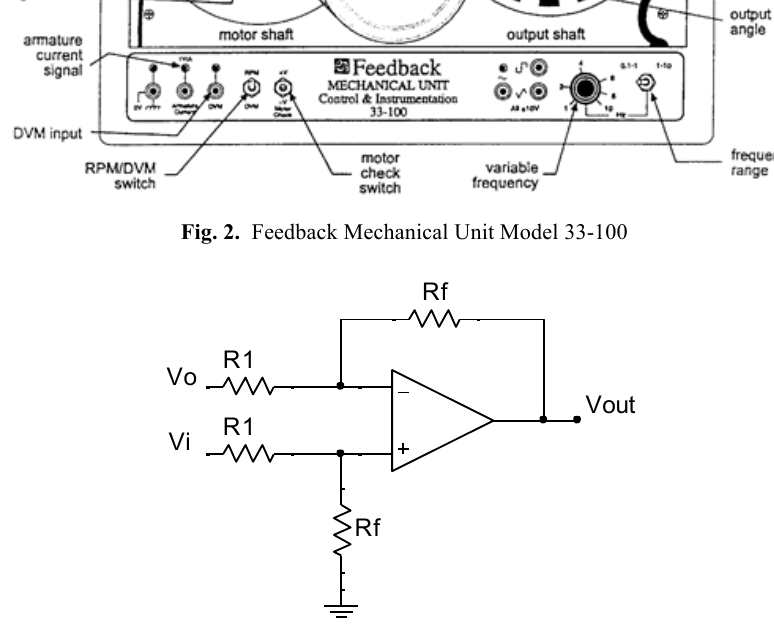
Fig. 3. Proportional